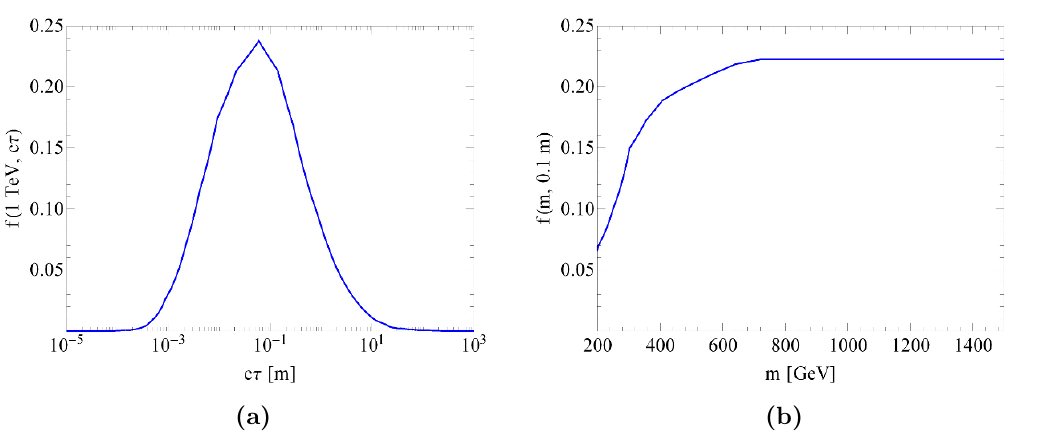
Figure 9. The e(cid:14)ciency for reconstructing a single vertex f ( m; c(cid:28) ) for (a) (cid:12)xed m = 1 TeV and (b) (cid:12)xed c(cid:28) = 0 : 1 m for the CMS search